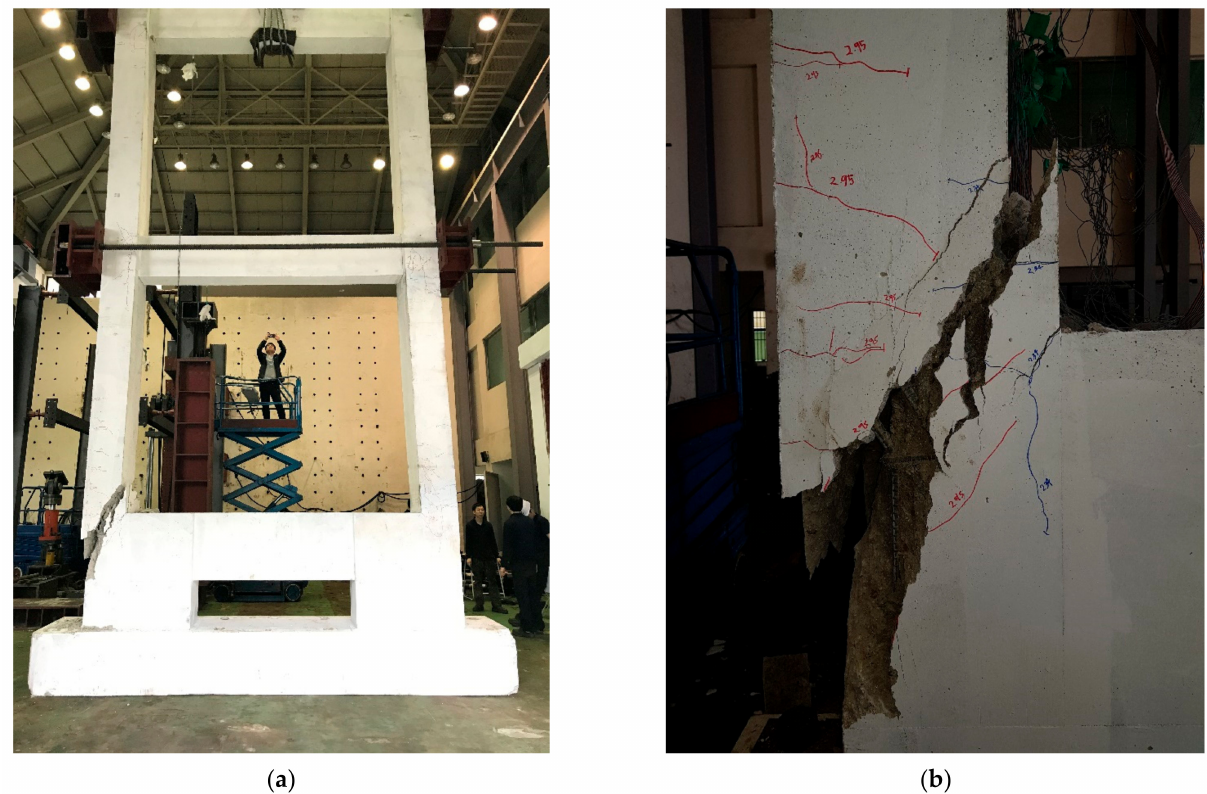
Figure 10. Cracks and ultimate failure of test frame with no reinforcement applied (PD-FR) (200 cm/s 2 ): ( a ) shear collapse at the final stage and ( b ) enlarged shear